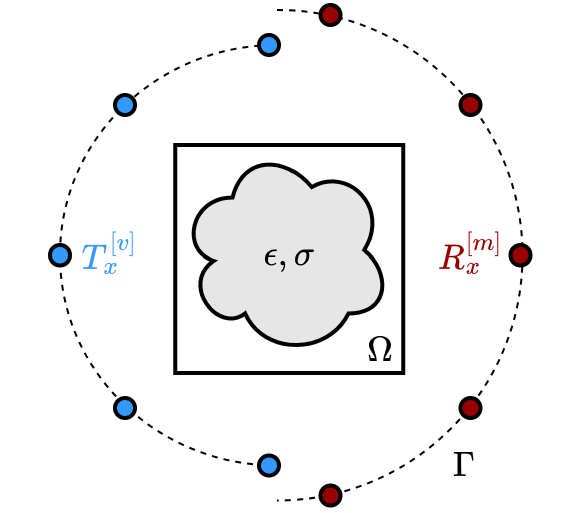
[ v ] [ m ] x and receiving R x